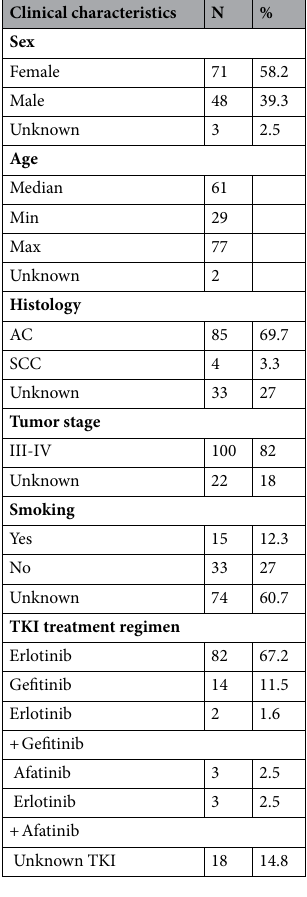
Table 1. Clinical characteristics of 122 Vietnamese NSCLC with acquired resistance to TKI drugs. N total case number, % percentage of